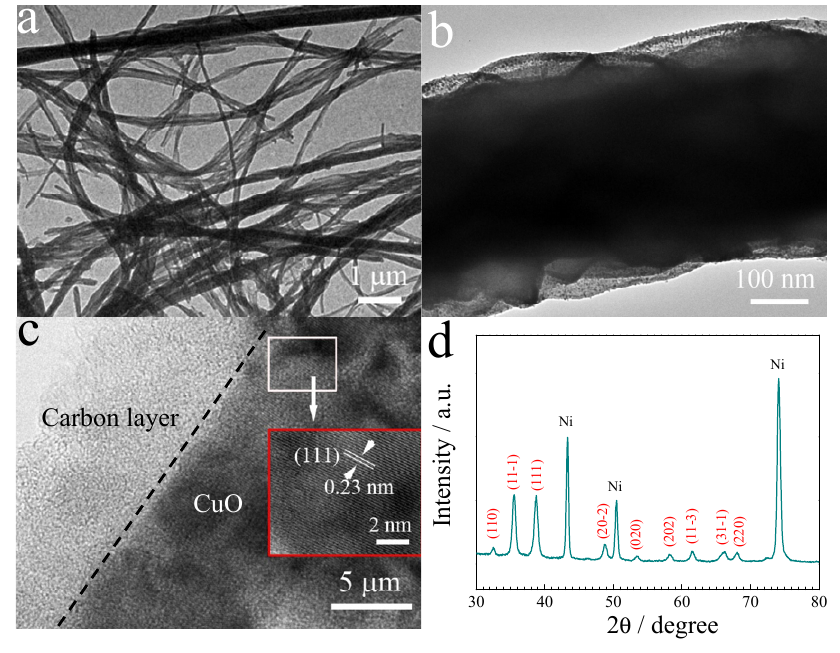
Figure 1. ( a ) Schematics of growth of CuO/C core/shell nanowire arrays; ( b – d ) Scanning electron microscopy (SEM) images of CuO/C core/shell nanowire arrays (inset: high-magnification SEM